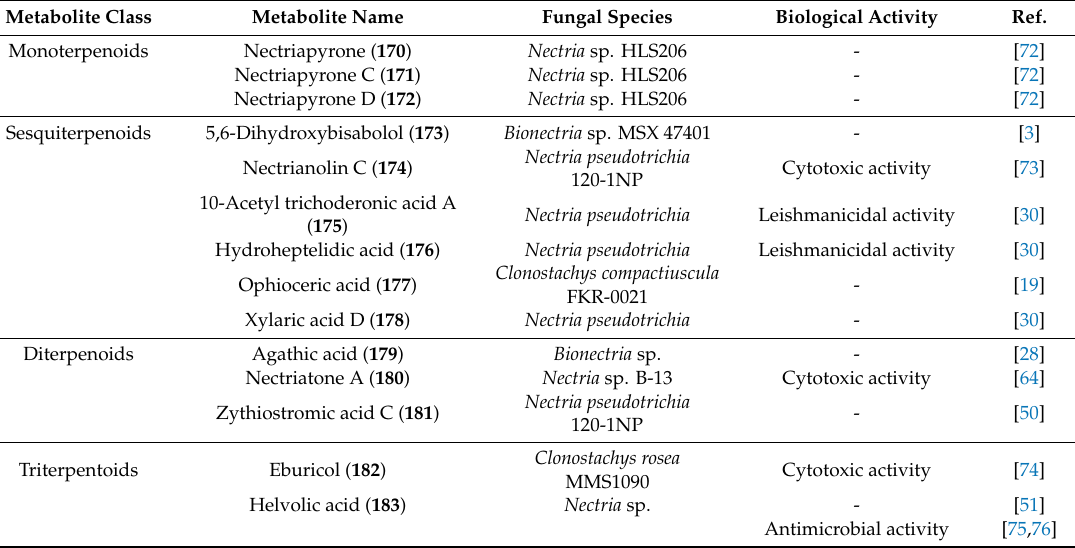
Table 3. Terpenoids in Clonostachys fungi and their biological